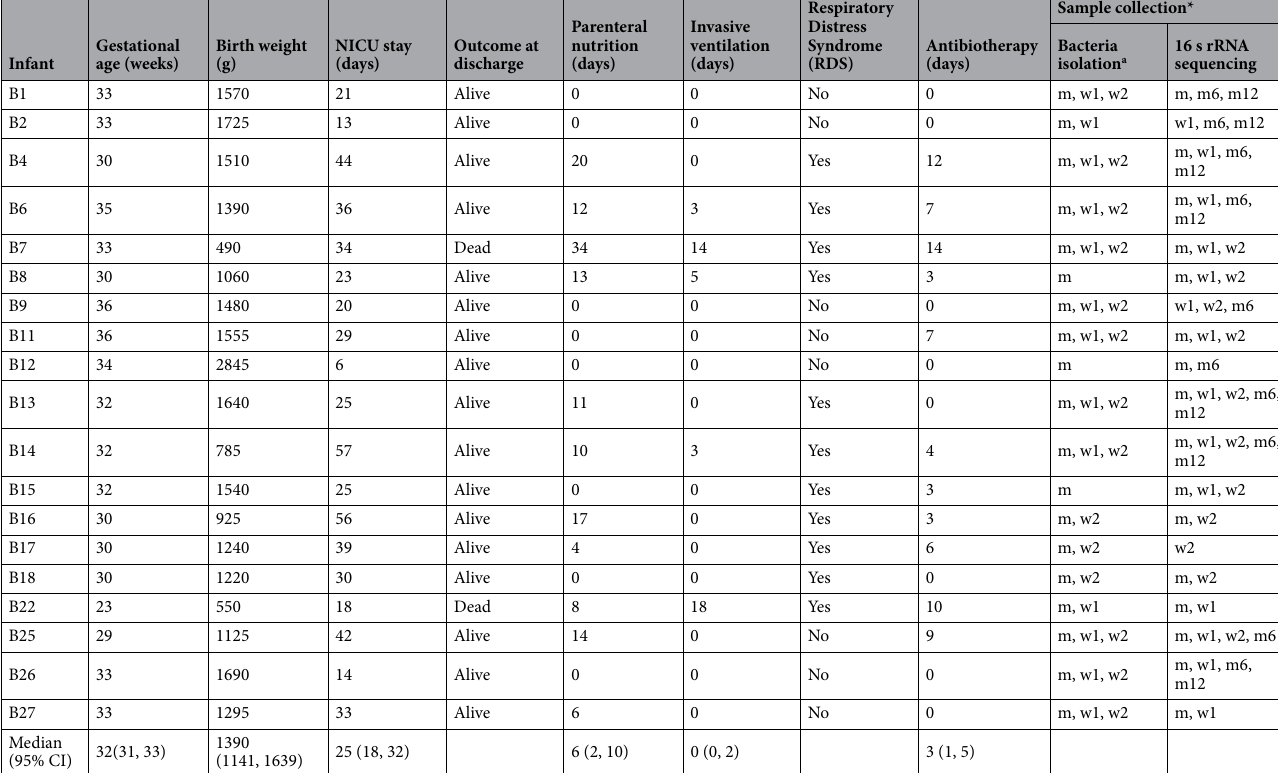
Table 2. Clinical characteristics of the preterm infants studied. *m, meconium; w1, week 1; w2, week 2; m6, month 6; m12, month 12. a Culture for samples collected during